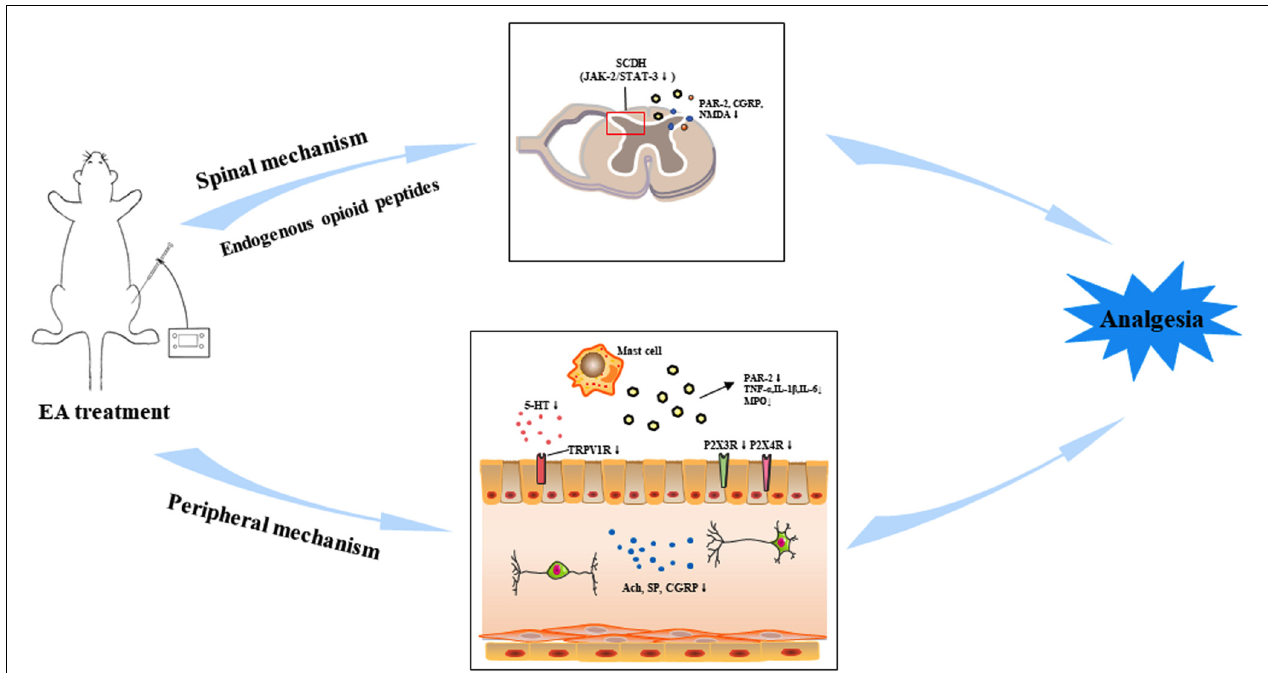
FIGURE 1 | Electroacupuncture (EA) can relieve visceral hypersensitivity (VH) through peripheral and spinal pathways in the brain–gut axis by the regulation of different neurotransmitters and their receptors. Abbreviations: Acetylcholine (Ach), substance P (SP), 5-hydroxytryptamine (5-HT), transient receptor potential vanilloid 1 (TRPV1), tumor necrosis factor-alpha (TNF- α ), interlukin-1 β (IL-1 β ), interlukin-6 (IL-6), myeloperoxidase (MPO) enzyme, protease-activated receptor-2 (PAR-2), calcitonin gene-related peptide (CGRP), N -methyl- D -aspartate receptors (NMDAR), Janus kinase-2 (JAK-2)/signal transducer and activator transcription